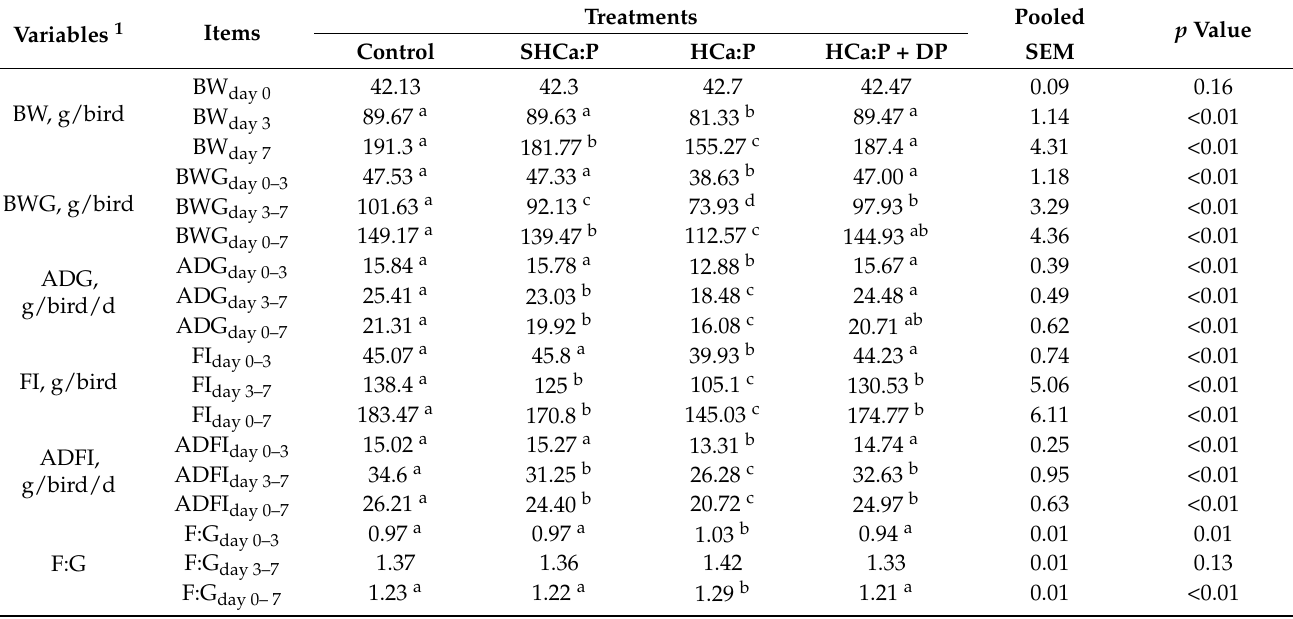
Table 6. Effect of high-calcium (Ca): phosphorus (P) ratio, P-deficient (HCa:P) crumbled feed on growth performance in 0- to 7-day-old broiler chicks during trial